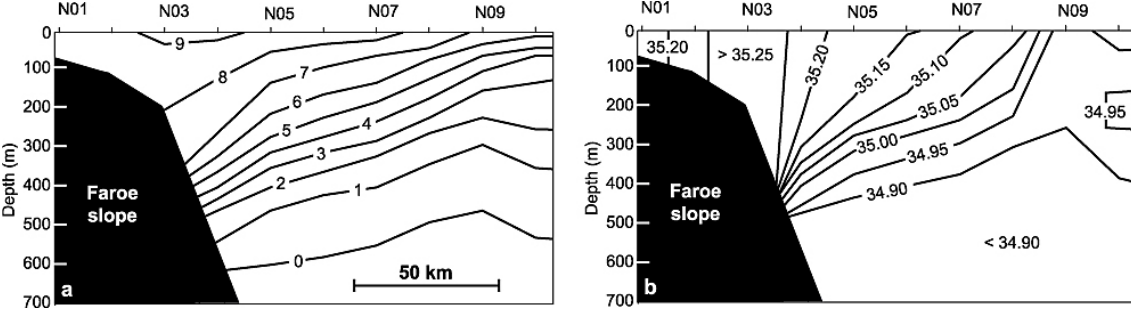
Fig. 2. Average temperature (a) and salinity (b) distribution on the standard section, based on 46CTD cruises